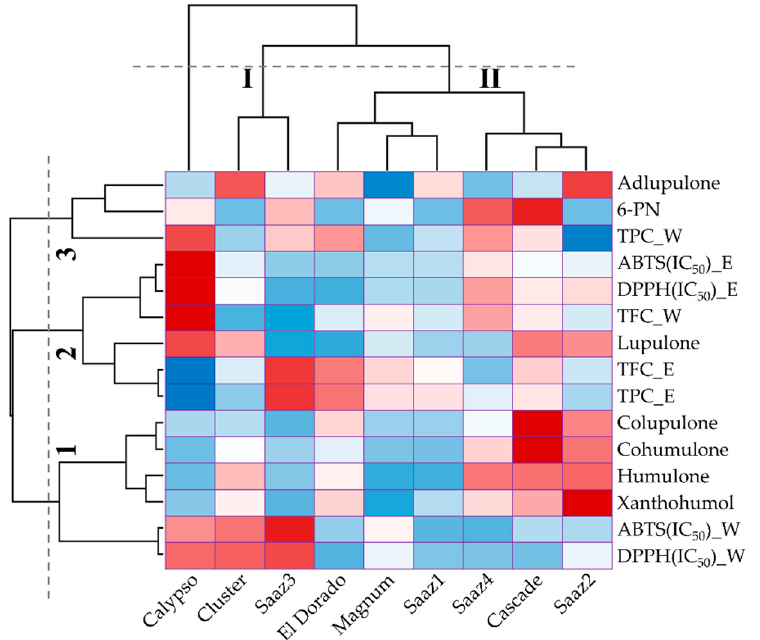
Figure 4. Hierarchical cluster analysis of nine different hop cultivars according to their phenolic levels and antioxidant activities.